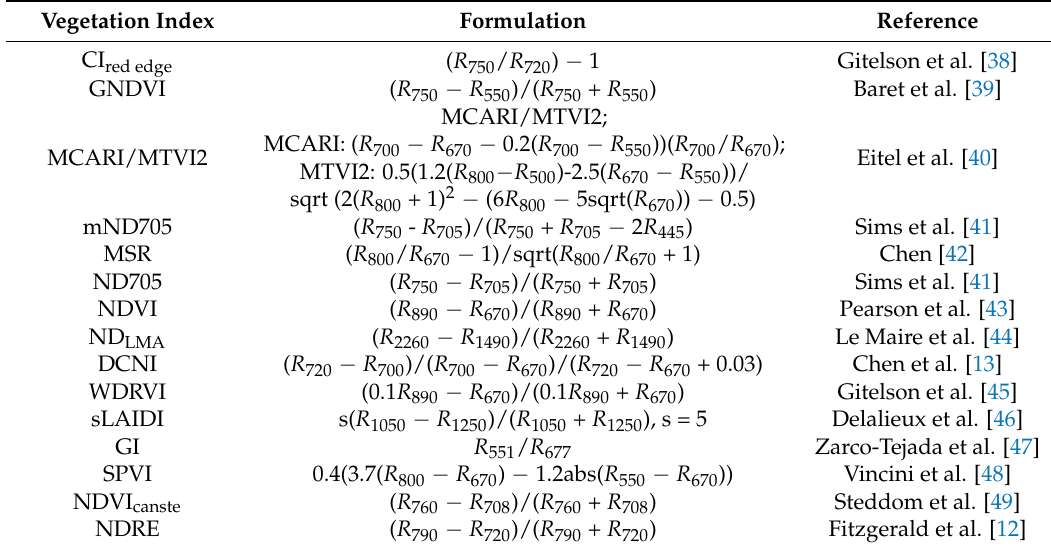
Table 4. Summary of vegetation indices studied for the N-PROSAIL inversion and N